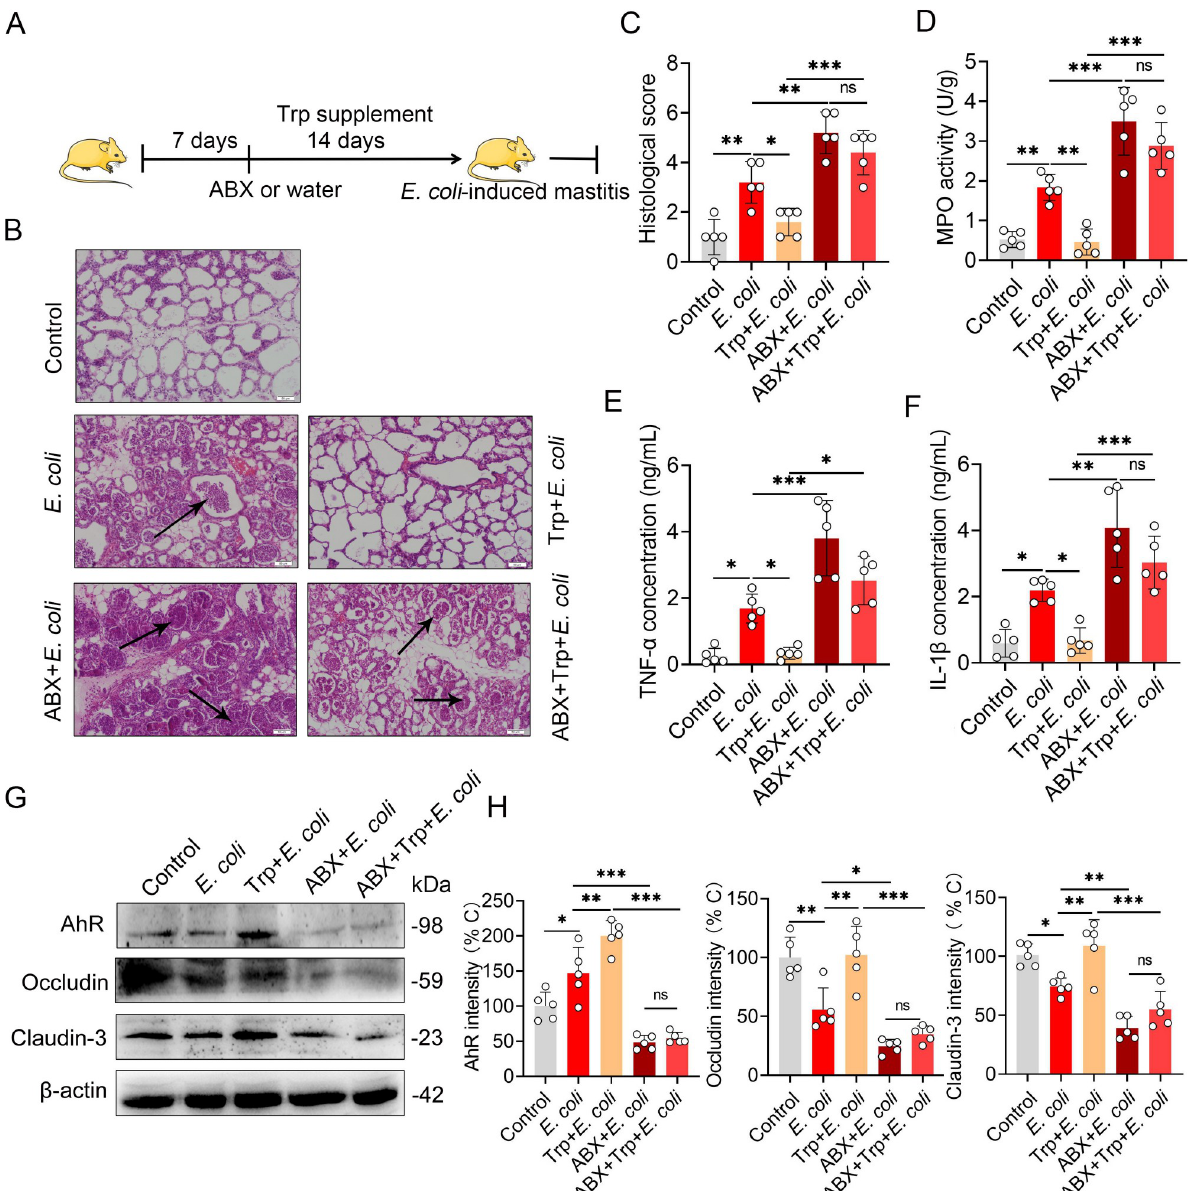
Fig 5. Tryptophan improves E . coli -induced mastitis by intestinal microbiota metabolism. (A) Schematic representation of tryptophan treatment. The mice were pretreated with ABX (1 g/L ampicillin, neomycin sulfate and metronidazole and 0.5 g/L vancomycin) or water for one week and their food was supplemented with or without tryptophan (1%) for two weeks, followed by modeling of the E . coli -induced mastitis (10 7 CFU/50 μ L by intra-breast injection). ( B ) Representative H&E staining of mammary gland tissue sections used in histological analysis. The black arrow indicates inflammatory cell infiltration (scale bar, 50 μ m). ( C) The histological score according to H&E staining sections (n = 5). ( D) The MPO activity was assessed in mammary gland tissues from differently treated mice (n = 5). Inflammatory markers TNF- α ( E ) and IL-1 β ( F ) were measured using ELISA on mice from different groups (n = 5). AhR, occludin and claudin-3 protein levels ( G ) and intensity analysis (n = 5) ( H ). ns, no significance, � p < 0.05, �� p < 0.01, and ��� p < 0.001 indicate statistical significance by one-way analysis of variance. The data are presented as the means ± SEM (C–F and H). ABX, a cocktail of antibiotics; Trp, tryptophan.